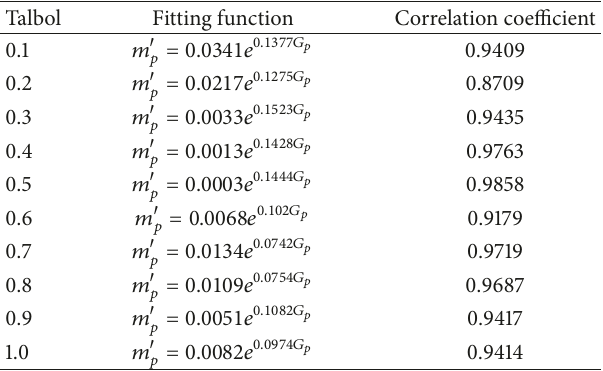
Table 6: Functional relationship of mass loss rate with pressure gradient and their correlation